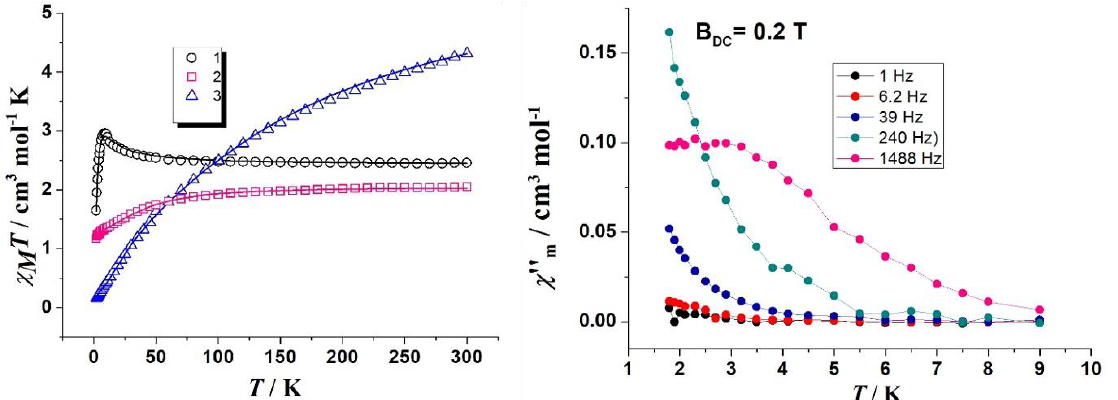
Figure 4. ( Left ) χ M T vs. T plots for complexes 1 (black circles), 2 (pink squares) and 3 (blue triangles). Solid line represents the best fit. ( Right ) χ M ″ vs. T plot for complex 2 at different frequencies under a dc field of 0.2 T.